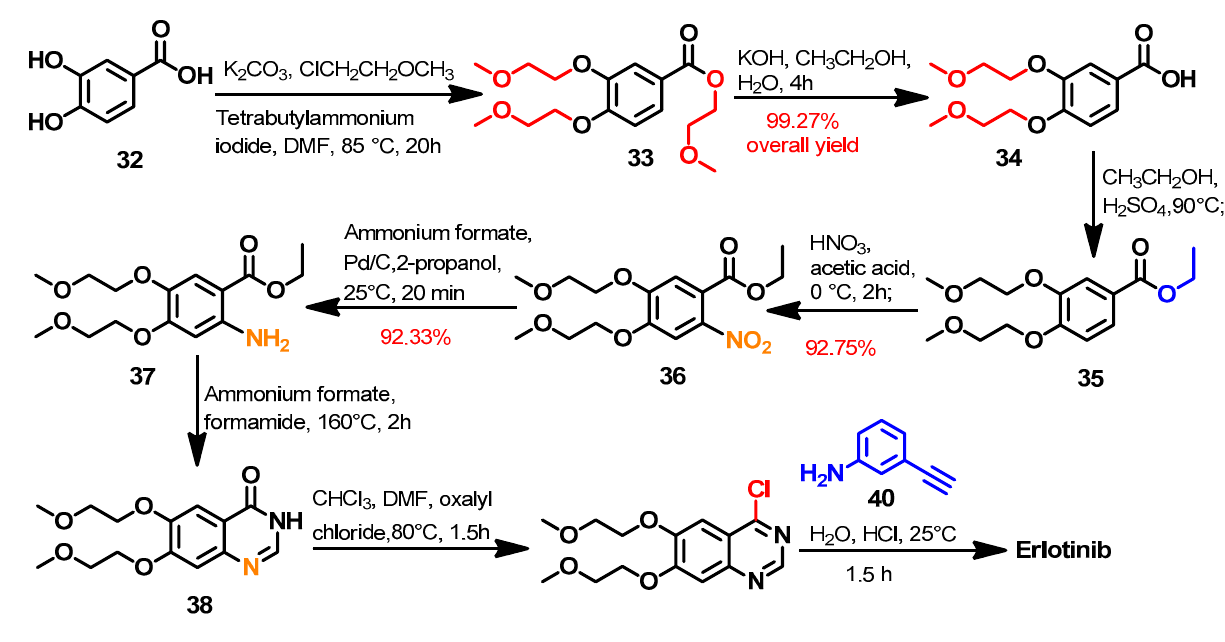
Figure 25. Chemical structure/name/synonyms of erlotinib.